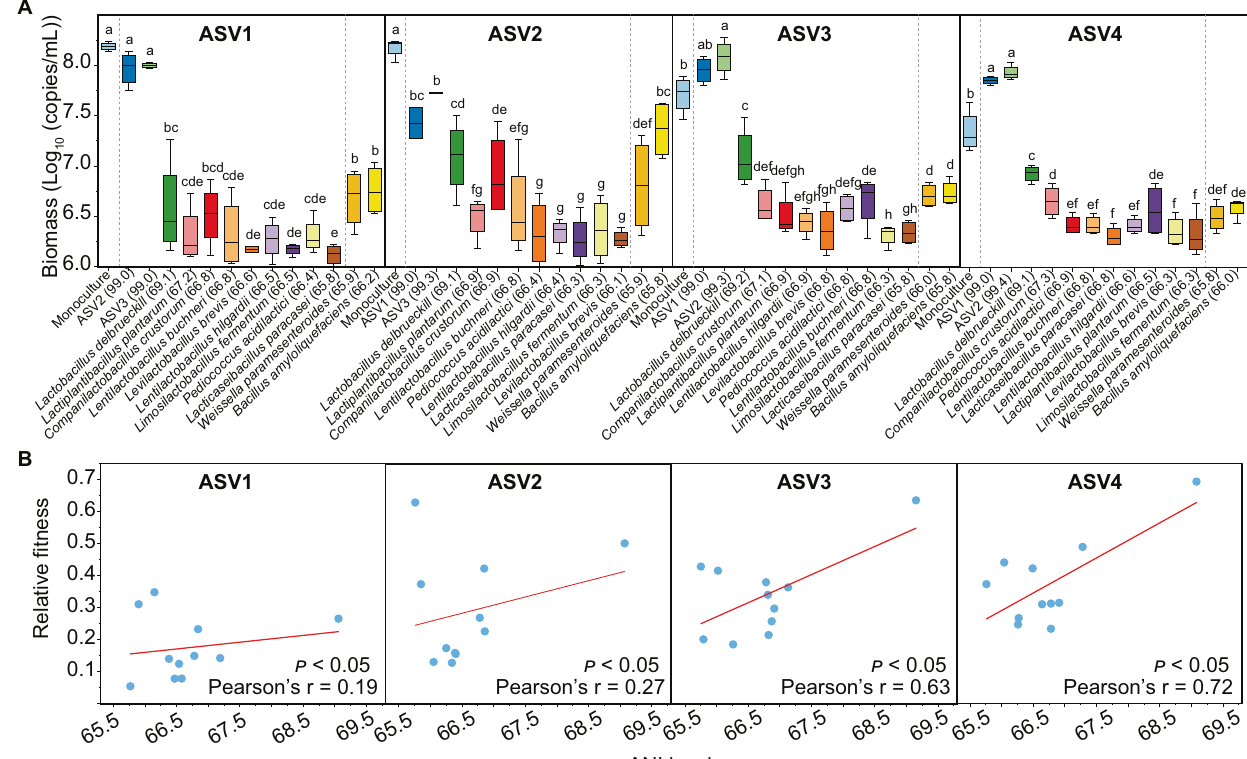
Fig. 1 Relative fi tness and biomass of different L. acetotolerans isolates in pairwise cocultures. A Biomass of different L. acetotolerans isolates from 4 ASV types in pairwise cocultures with 11 other bacterial species. The other species cocultured with L. acetotolerans are indicated on the abscissa, and the number in the brackets after the species name indicates the ANI level (%) between L. acetotolerans isolate and other species. All cultures were under static and anaerobic conditions at 30 °C, and the biomass were determined on Day 8. Each culture had four biological replicates. Unlike letters indicate signi fi cant differences ( t -test, p < 0.05). B Correlation of relative fi tness of L. acetotolerans and ANI level between L. acetotolerans and 11 other species in pairwise cocultures. The red line represents fi tted curve between relative fi tness and ANI